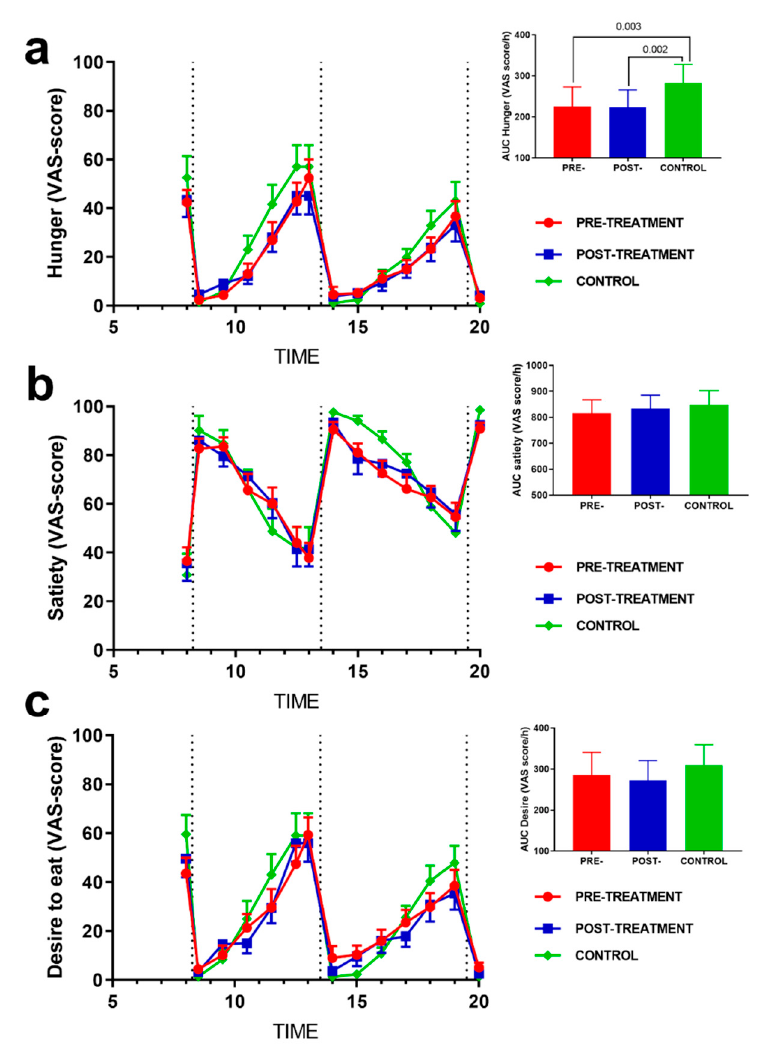
Figure 3. Comparison of ( a ) subjective hunger, ( b ) satiety, and ( c ) desire to eat ratings in the subjects with obesity pre- and post-intervention and in the control subjects. The vertical dotted lines indicate the time of breakfast, lunch, and dinner. Mean ± SEM. The differences between the groups were analyzed by a two-way (time × group) repeated-measures ANOVA.